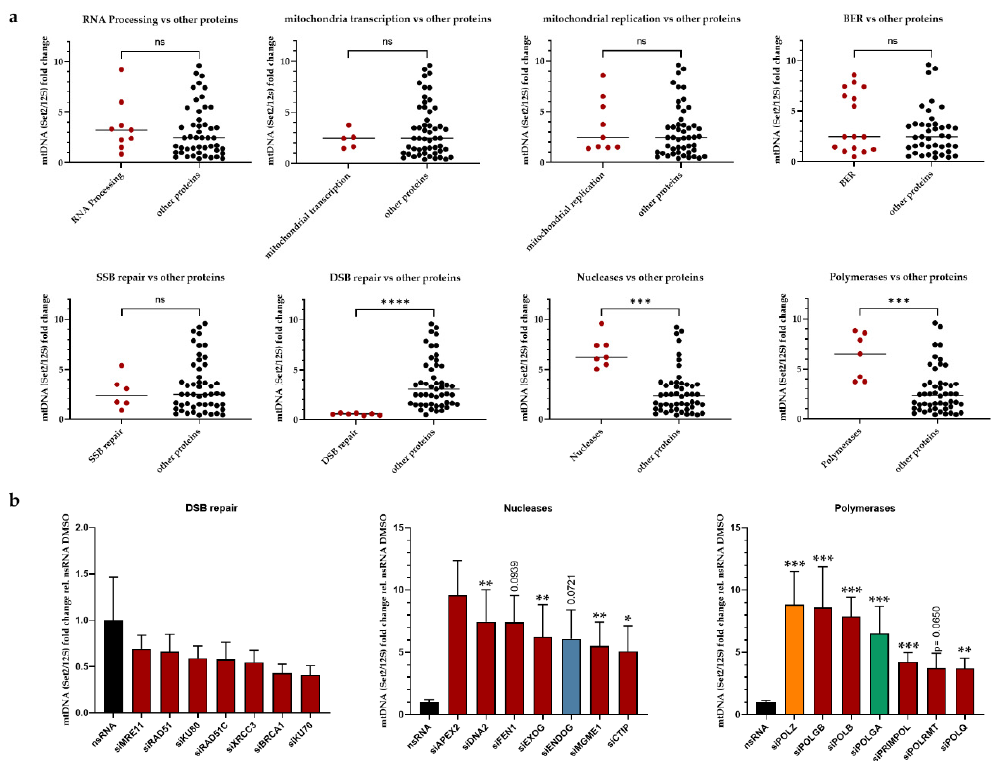
Figure 3. Analysis of functionally different groups. Mean mtDNA (Set2/12S fold change rel. to nsRNA) values for candidates included in the siRNA screening were functionally grouped and compared to the group of remaining candidates to identify the most significantly altered function ( a ). For individual candidates from significantly altered groups, individual differences compared to the control (nsRNA) were calculated ( n = 6–8 from 4 independent experiments) ( b ). For group annotations, see Supplementary Table S1. All values are means ± SEM (* p ≤ 0.05, ** p ≤ 0.01, *** p ≤ 0.001 and **** p ≤ 0.0001); ns, not